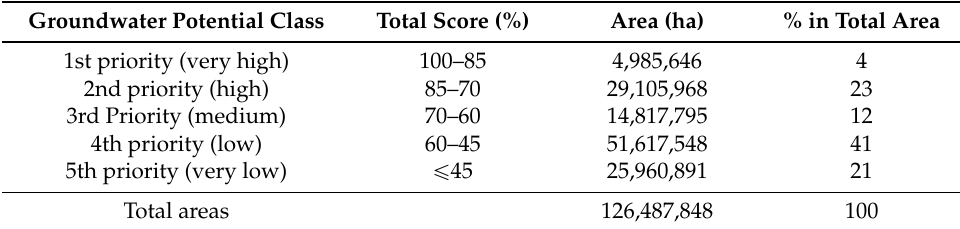
Table 3. Prioritization of watersheds across Mali with %